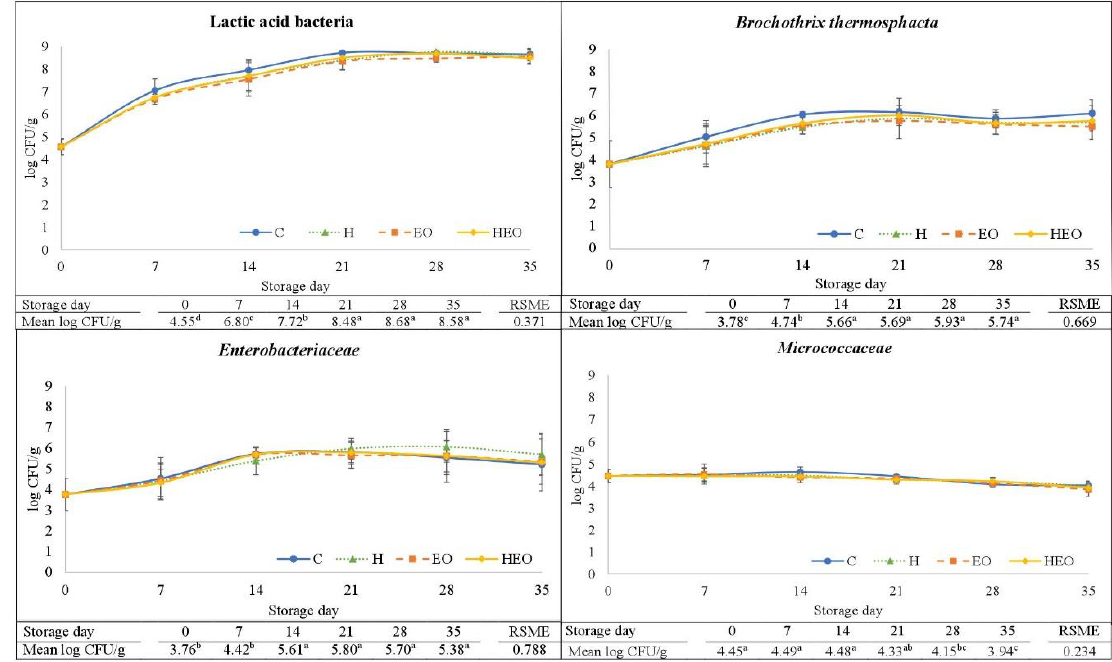
Figure 1. Effect of the addition of different natural antimicrobial sources on lactic acid bacteria: Brochothrix thermosphacta , Enterobacteriaceae , and Micrococcaceae counts (mean values, n = 3, and standard deviation, vertical bars) in fresh lamb sausages packaged under modified atmosphere (80% N 2 , 20% CO 2 ) during refrigerated storage (4 °C). CFU: Colony forming units. RSME: Root square mean error. C: Control sausages; H: hops; EO essential oil ( Zataria multiflora Boiss); HEO: hops and essential oil. abcd : Total means ( n = 12) with different superscripts time-related indicate statistical differences (Tukey test, P < 0.05).